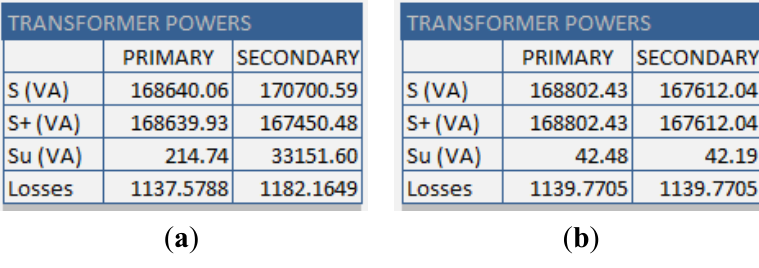
Figure 12. Transformer powers: ( a ) not distributed the wye load; ( b ) optimal wye load